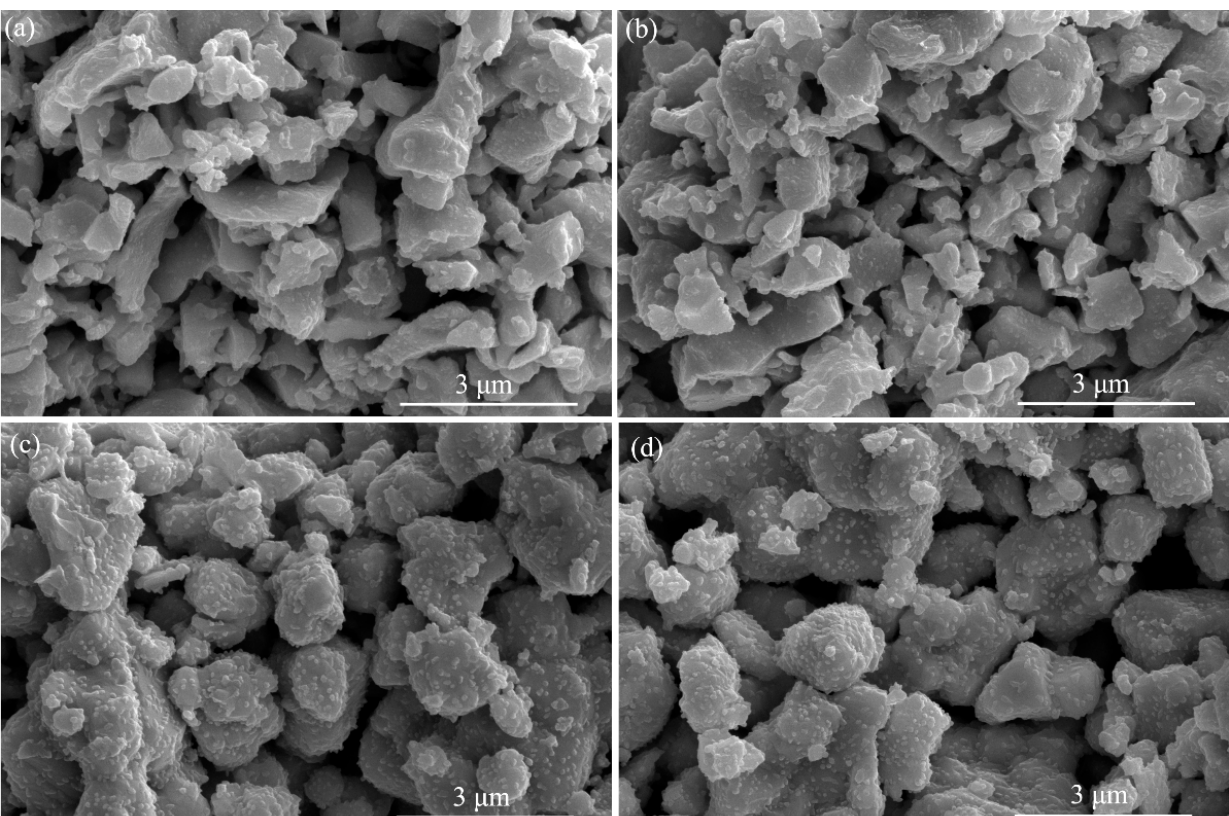
Figure 2. SEM images of LBCM x ( x = 0–0.06) sintered at 950 °C for 2 h: ( a ) x = 0, ( b ) x = 0.02, ( c ) x = 0.04, and ( d ) x = 0.06.